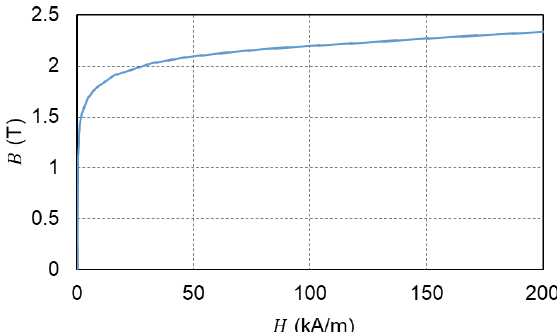
Figure 2. Magnetic characteristic B − H of the steel